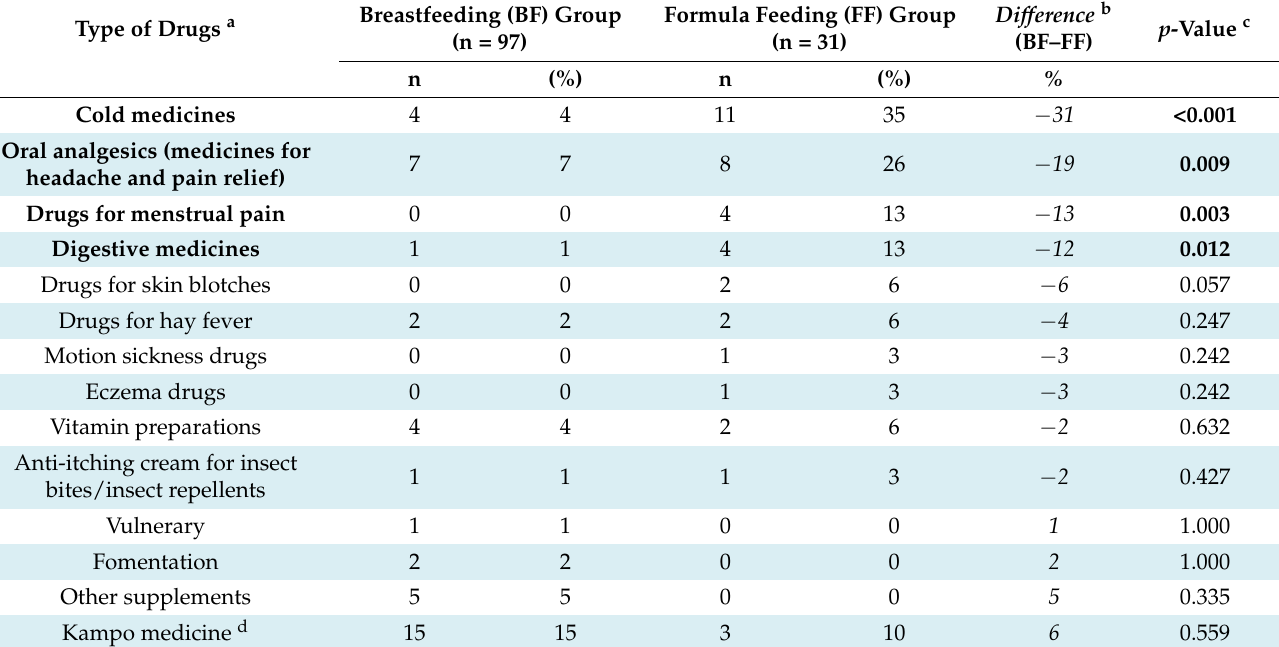
Table 2. Women’s use of nonprescription drugs in the postpartum period.